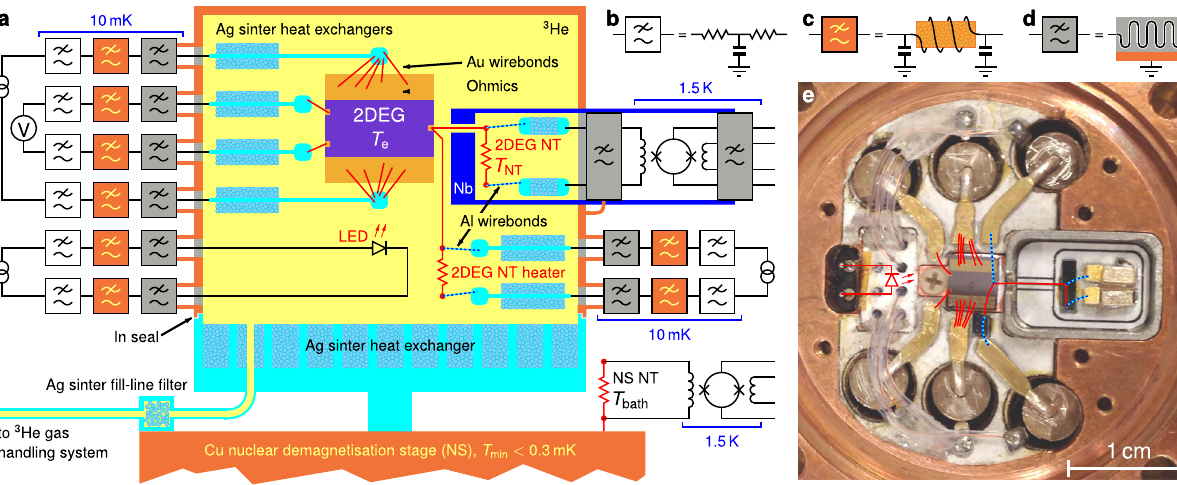
Fig. 2 Experimental platform for cooling low-dimensional electrons. a Schematic diagram of the metal immersion cell. Silver sinter on the silver base thermalises the liquid 3 He to the nuclear demagnetisation refrigerator. The copper lid holds the 2DEG device, the sinter heat exchangers for cooling the I± and V± lines, the 2DEG noise thermometer (NT), and a red light-emitting diode (LED) for illuminating the 2DEG. The NT and its heater were connected using wedge-bonded resistive Au wires and superconducting Al wires acting as thermal breaks 62 . Another NT is mounted on the nuclear stage (NS) to measure the 3 He bath temperature T bath . The base and the lid sealed with In comprise a He-tight and photon-tight enclosure, complete with a Ag sinter plug in the fi lling capillary. All incoming electrical connections are fi tted with low-pass fi lters of three types: b discrete RC fi lters with R = 1 k Ω and C = 10 nF, c insulating Cu powder fi lters 63 , and, d Ag epoxy fi lters with 1 m-long NbTi wires embedded in conducting Ag epoxy. RF-tight coaxial connections were used between these fi lters and the walls of the immersion cell. Ag epoxy fi lters with multiple wires, compatible with SQUID NT readout, were used on the SQUID lines. e The inside of the copper lid of the cell, with the Au and Al wires highlighted and the LED shown schematically. The NT is housed in a Nb shield, shown here with the top removed.